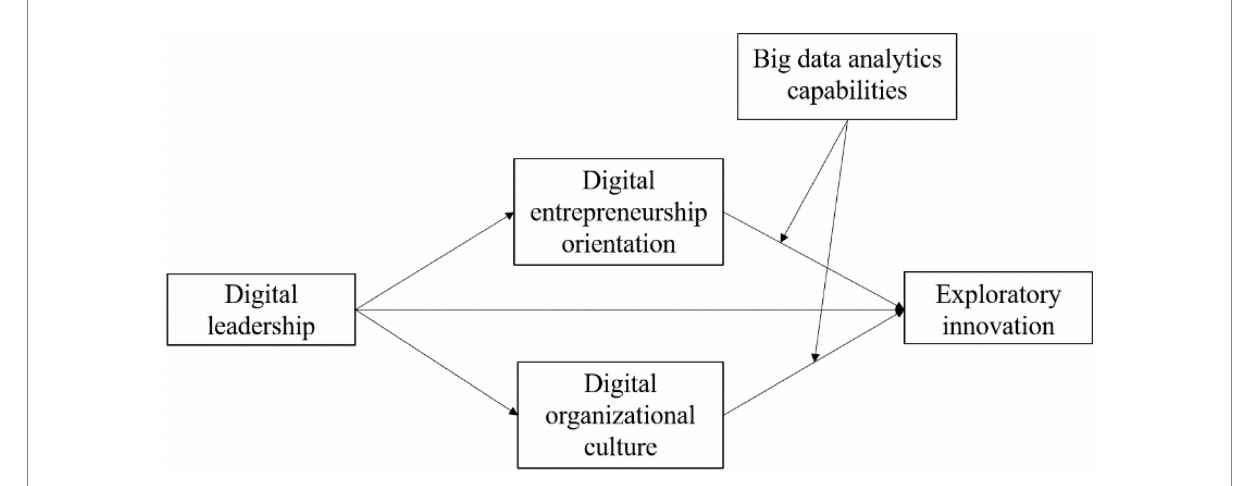
FIGURE 1 The hypothesized